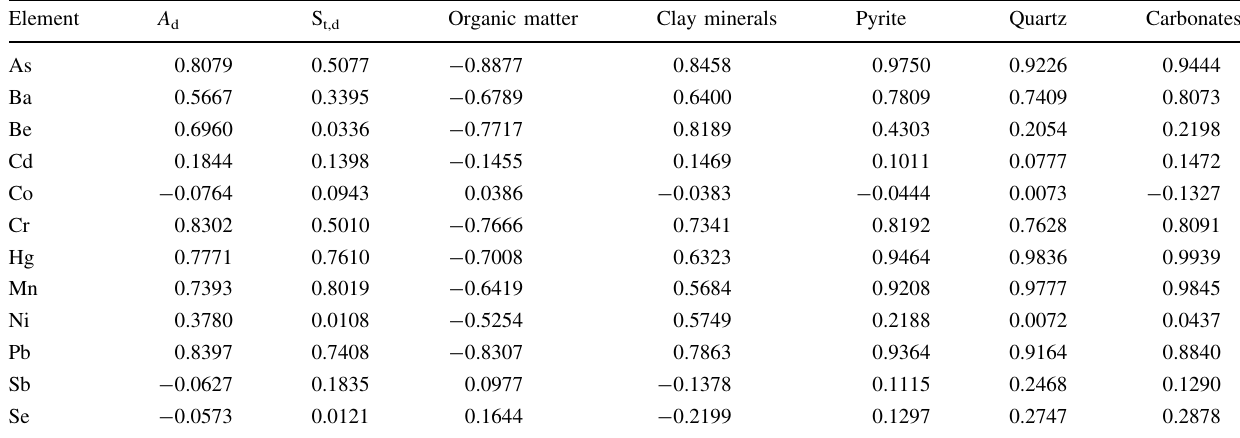
Table 5 Correlation coefficients showing relationships between trace elements and organic matter, minerals, ash and sulfur Element As